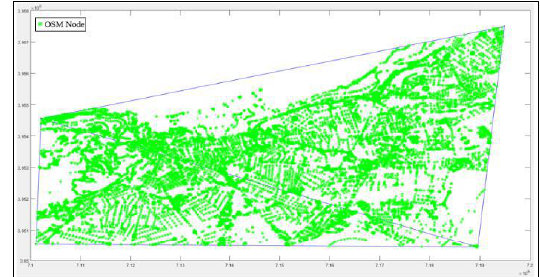
Figure 11. OSM node after reading the road network (green